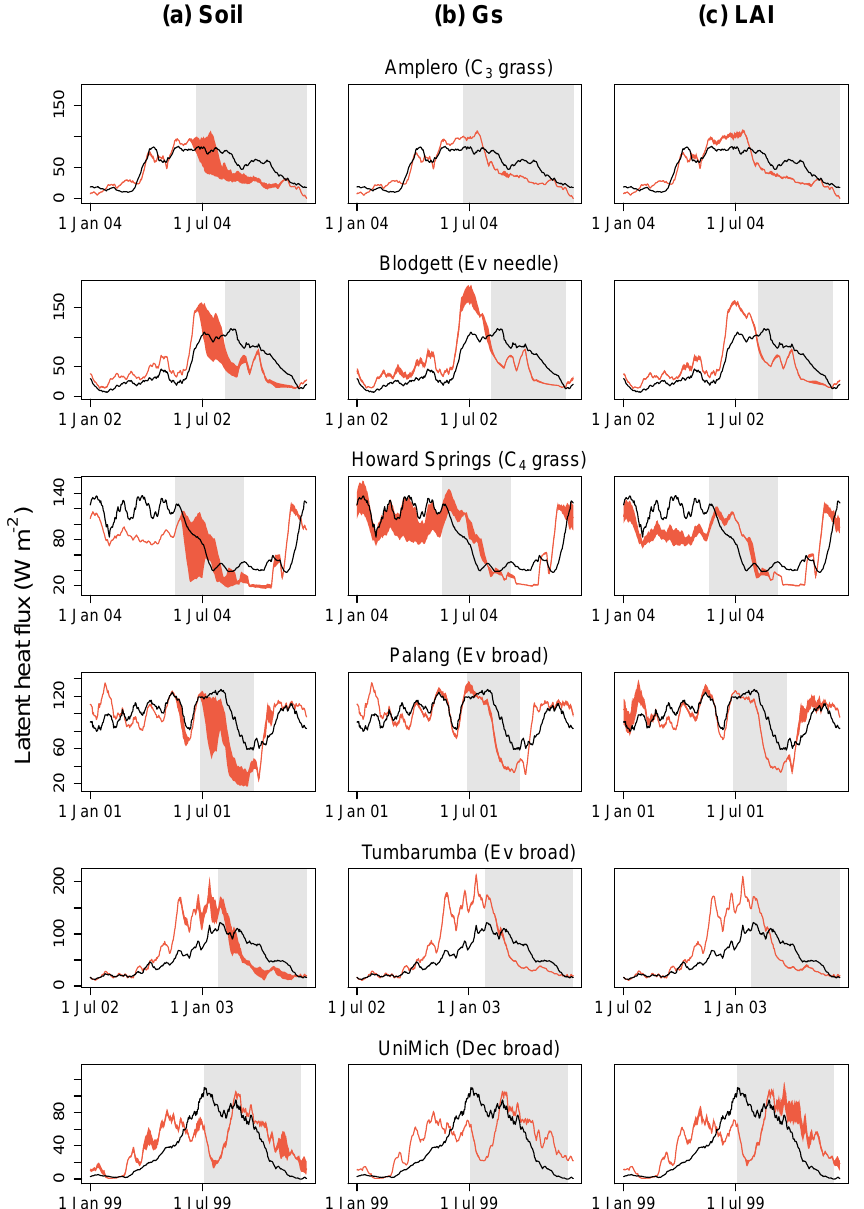
Figure 6. The range in simulated latent heat (red) arising from the individual effects of soil parameters (left panel), g s (centre panel) and LAI (right panel) using the default hydrological scheme during the 1-year period. Observed latent heat is shown in black. The grey shading denotes the selected dry-down period. The individual effects were determined by fixing the other parameterisations at their default values (medium soil, Medlyn g s and centre